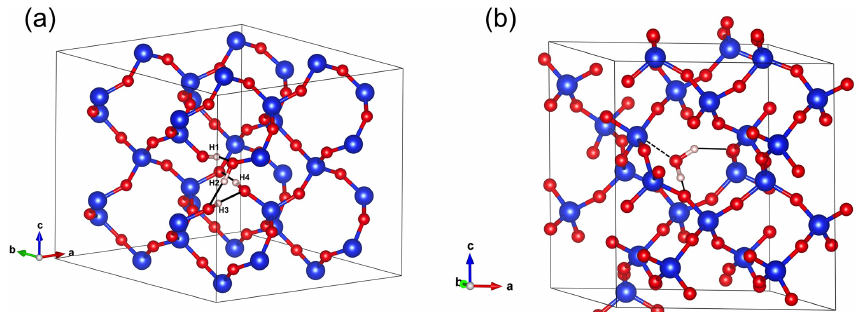
Figure 4. (a) Structure of the hydrogarnet ((4H) × ) defect. Note the H bonds represented by the black plain lines. Those involving the H1, H2 Si and H3 atoms are oriented along the edges of the tetrahedral site. The OH4 group points out of the tetrahedral site. (b) Structure of interstitial H 2 O. Note the weak bonding to a Si atom (doted line) and the H-bond pattern (black plain lines). In this and following figures, silicon atoms are in blue, oxygen atoms in red and hydrogen in light